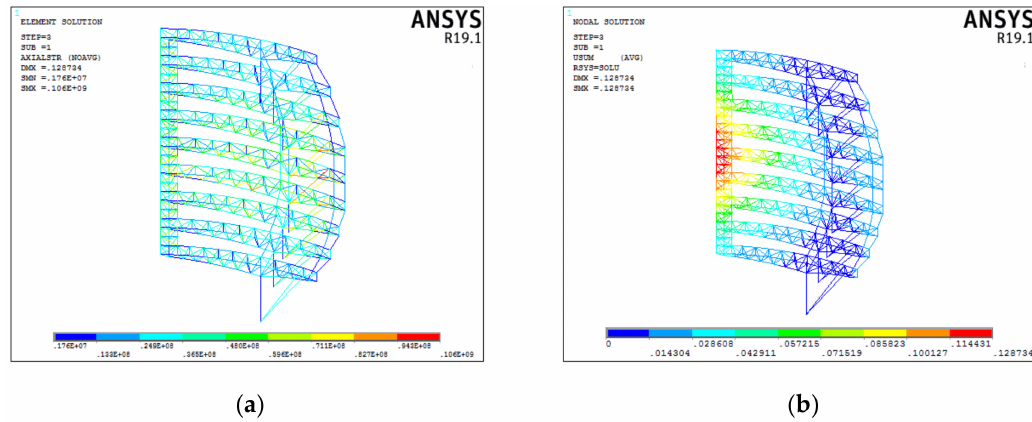
Figure 11. Finite element results: ( a ) Axial stress; ( b ) relative